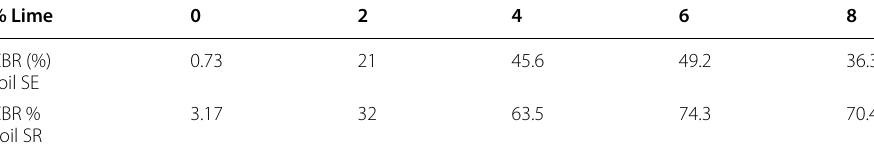
Fig. 6 Effect of lime on CBR of samples cured for 7